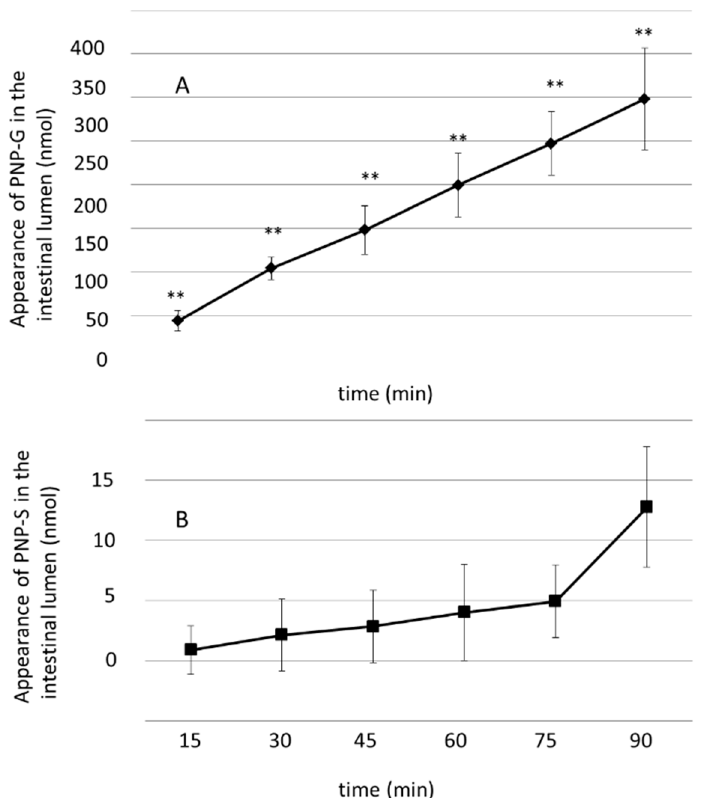
Figure 2. Luminal appearance of p -nitrophenol-glucuronide (PNP-G) ( ♦ ) (Panel A ) and p -nitrophenol–sulfate (PNP-S) ( ■ ) (Panel B ) in the small intestine (proximal jejunum) measured in 90 min perfusion of 500 µM PNP. Values represent the mean ± S.D. of eight rats. Significant difference between the values of PNP-G and PNP-S: ** p < 0.01.